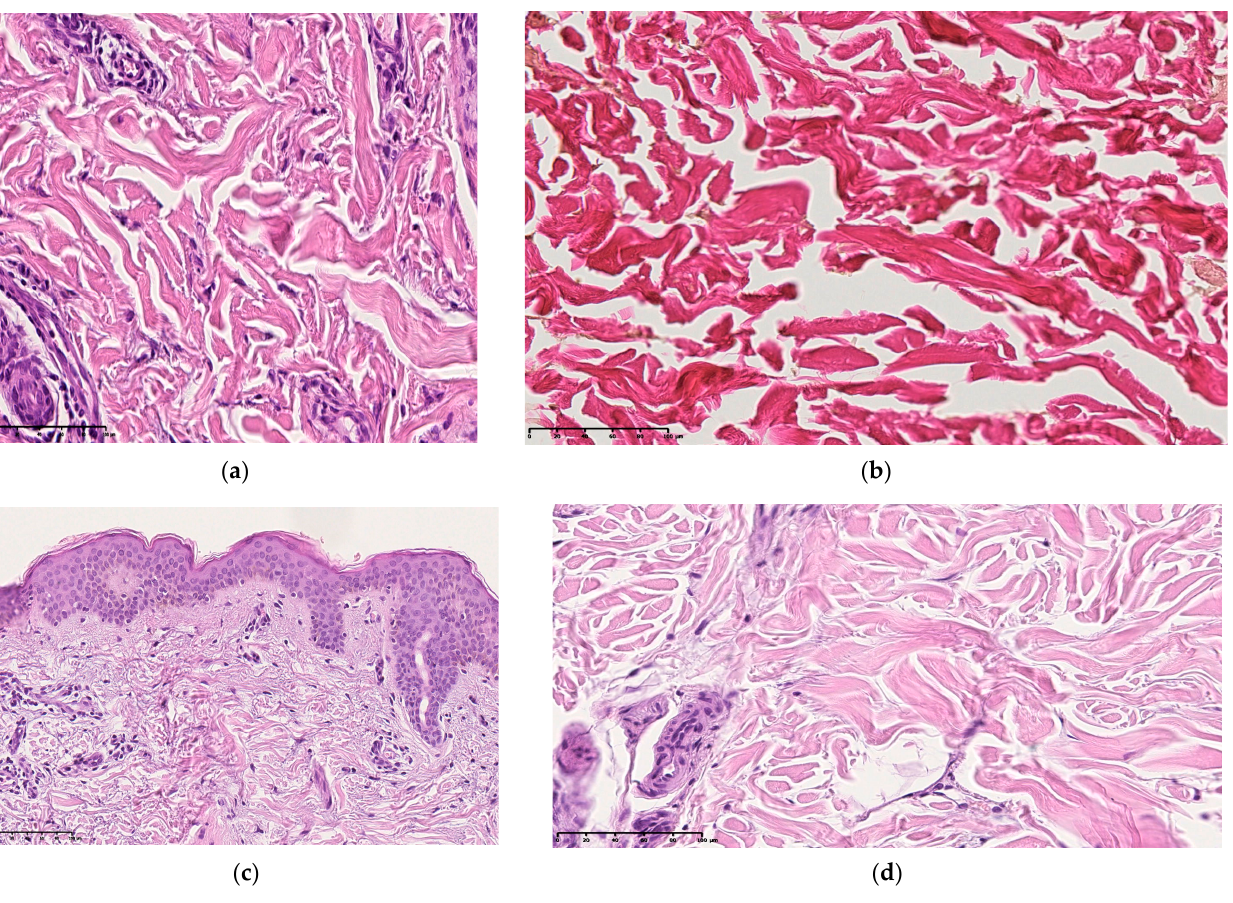
Figure 7. Micrography of the skin section after hyaluronic acid treatment: ( a ) in comparison group stained with hematoxylin and eosin, ×200, ( b ) in comparison group stained according to the Van Gieson method, ×200, ( c ) in main group stained with hematoxylin and eosin, ×100, ( d ) in main group stained with hematoxylin and eosin, ×200.